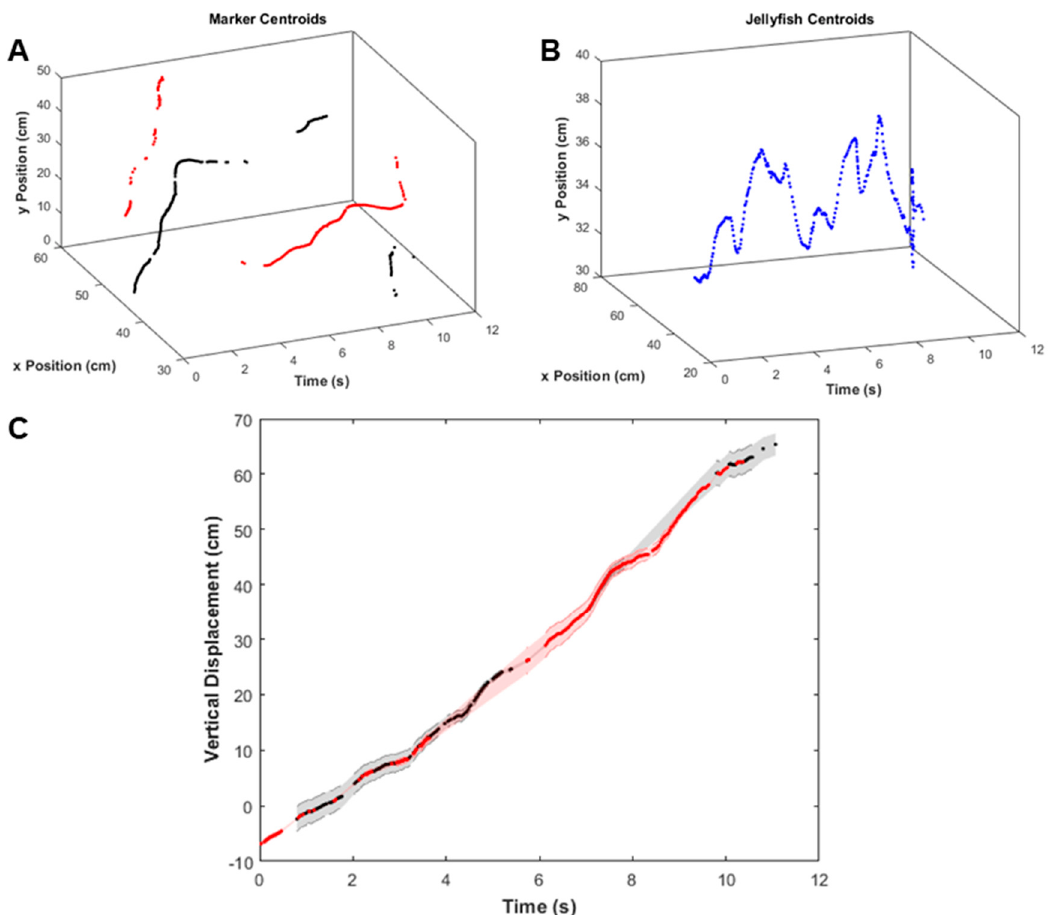
Figure A1. Representative plots tracking animal displacements over time to calculate vertical swimming speeds. To calculate the animals’ displacement over time with respect to the rope, a prominent background feature as a ground truth, we first tracked ( A ) centroids of the red and yellow markers on the rope in each image frame. A sample from one video (animal 1 driven at 0.75 Hz) is shown, with red markers plotted in red and yellow markers plotted in black for improved visualization. ( B ) Centroids of the jellyfish (by tracking the blue polypropylene housing) in each image frame over time. ( C ) Vertical displacement over time of the jellyfish with respect to the rope (data also presented in Figure 4 of the main), with the error propagated from conversions in pixel space to centimeter space. Tracks were assembled by stitching vertical positions using both red and yellow markers (shown in red and black, respectively), to show accuracy in overlap.